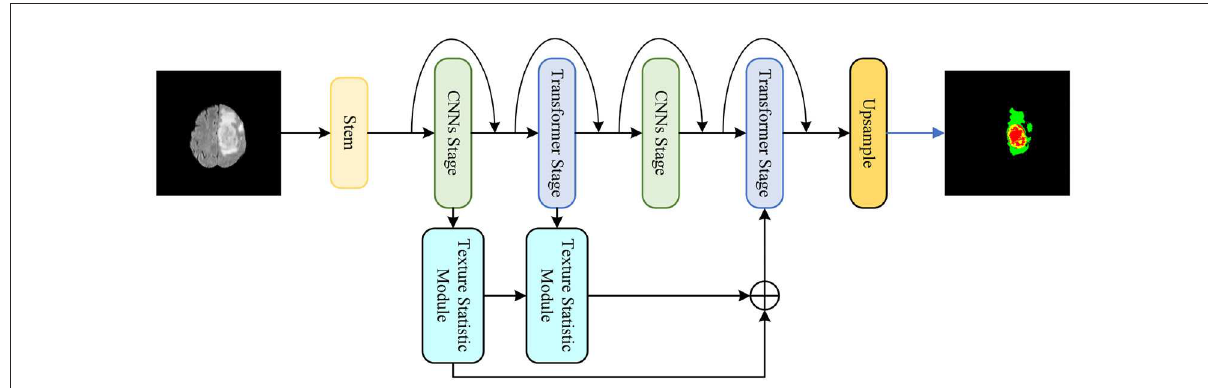
FIGURE1 The proposed medical image segmentation method based on multi-dimensional statistical